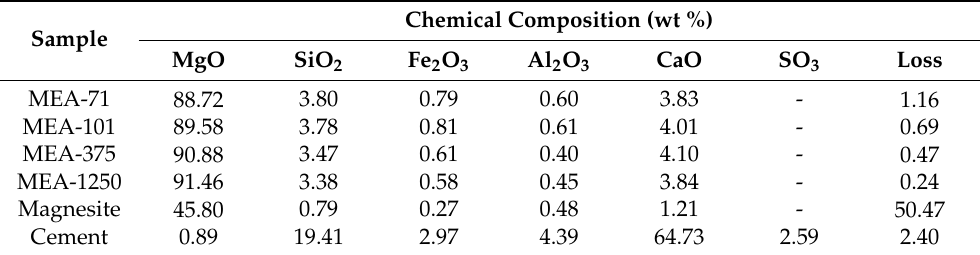
Table 1. Chemical compositions of MgO-type expansive agents (MEAs), magnesite and cement.